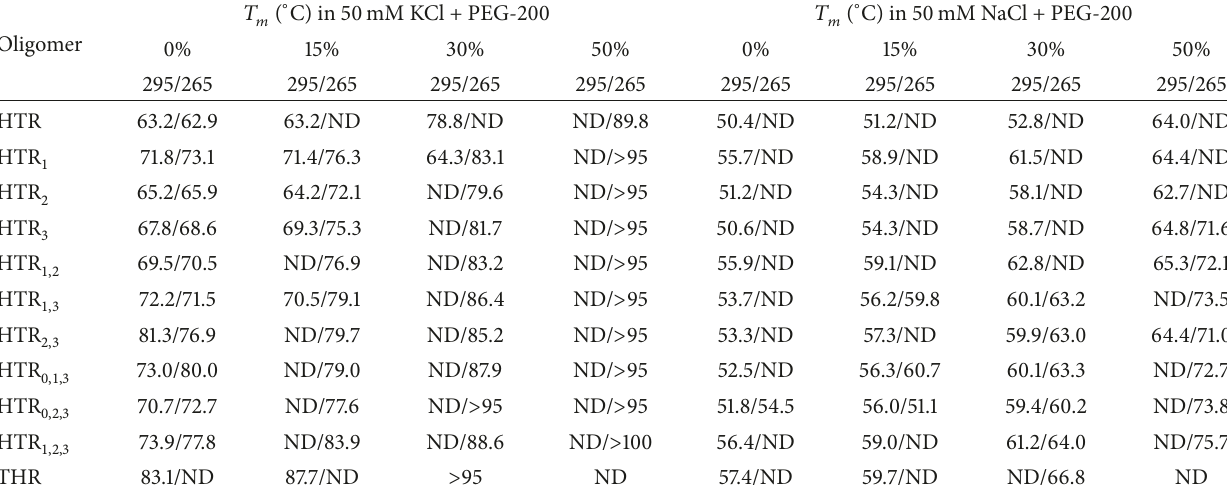
Table 2: Influence of PEG-200 on the melting temperatures of DNA oligomers in the presence of potassium and sodium ions.